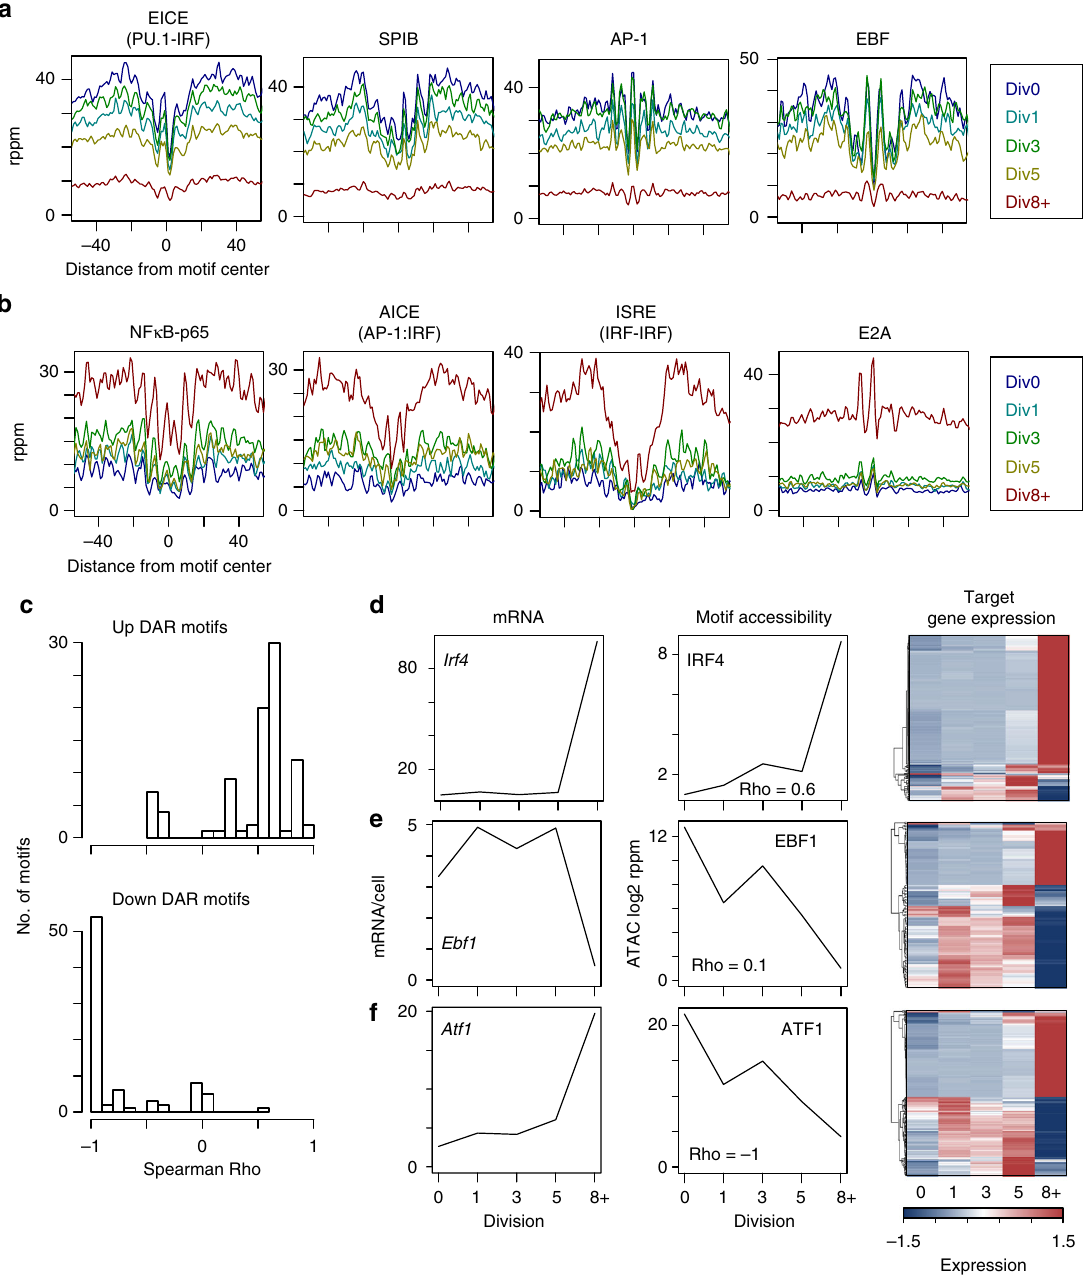
Fig. 3 Transcription factor networks program accessibility changes. ATAC-seq derived transcription factor footprints at each division for the indicated motif that was enriched in either down ( a ) or up ( b ) DAR is shown. c For each transcription factor binding motif, the average accessibility was calculated and correlated with the expression of the transcription factor across all divisions. Correlations were plotted as Spearman Rho coef fi cient vs. number of motifs that lost (Down) or gained (Up) accessibility. d – f For select motifs from c the expression at each division (left), the accessibility of the motif (middle), and the expression of the predicted target genes (right) is plotted. The Spearman Rho coef fi cient for each comparison is